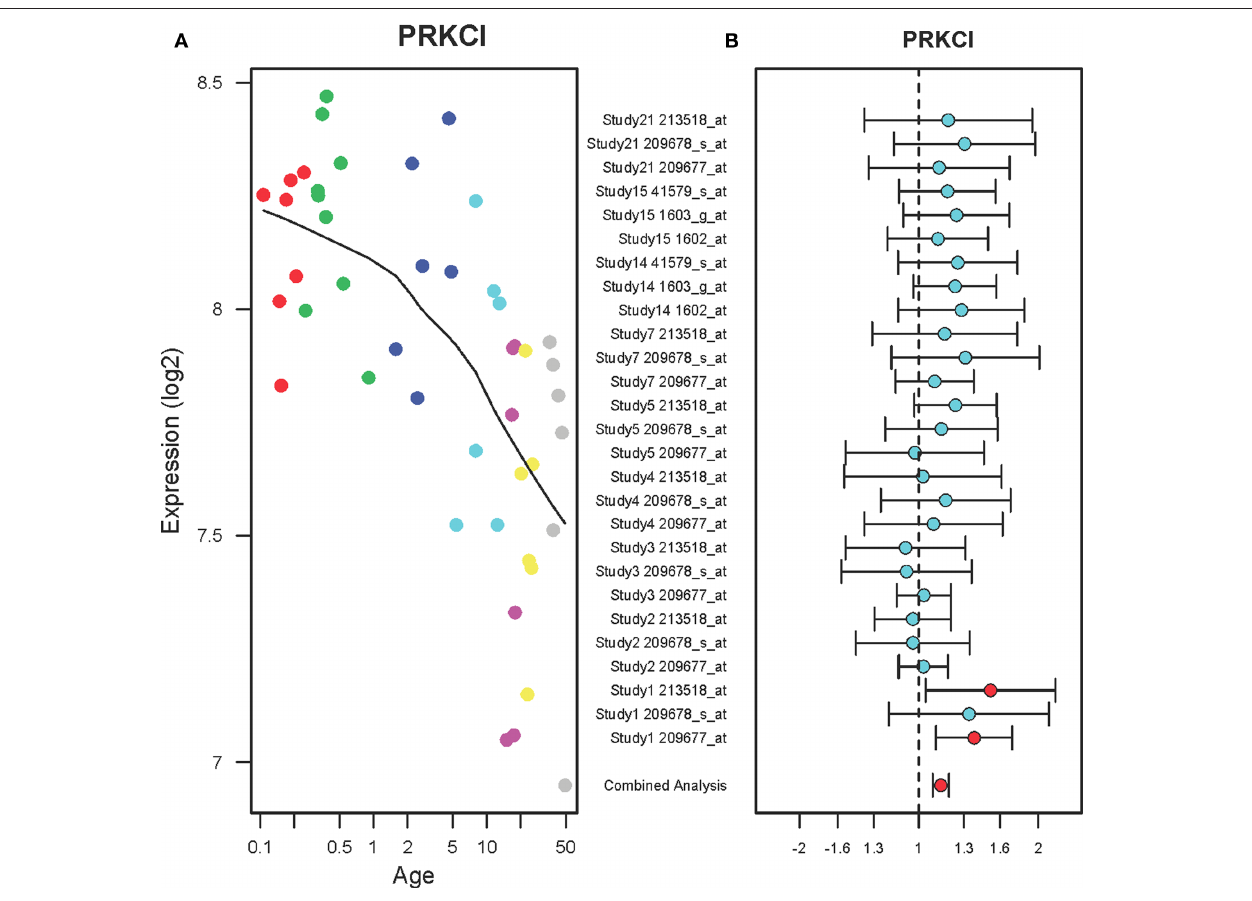
changes and 95% confidence intervals shows consistent up-regulation of PRKCI in the PFC of suicide victims as compared to the non-suicide controls across nine microarray studies. A combined analysis shown on the bottom represents the weighted fold change and 95% confidence intervals. Individual microarray probes for PRKCI across multiple studies are shown on the left (Study ID and Affymetrix probe ID). Red point: adjusted p < 0.05, Cyan point: adjusted p